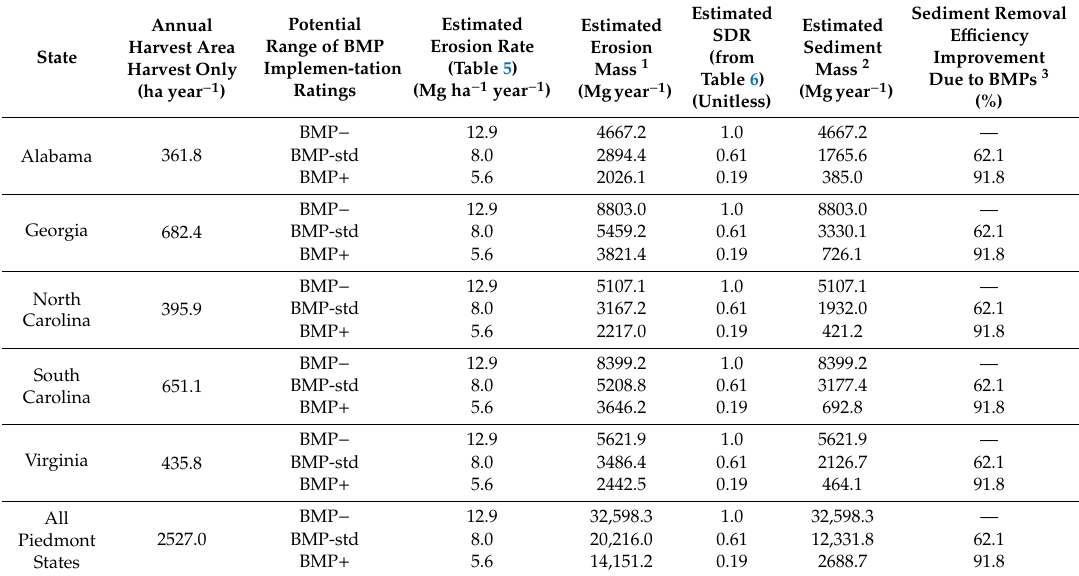
Table 9. Estimated erosion rates, erosion, masses, sediment delivery, and sediment removal e ffi ciencies due to BMP implementation levels by state for